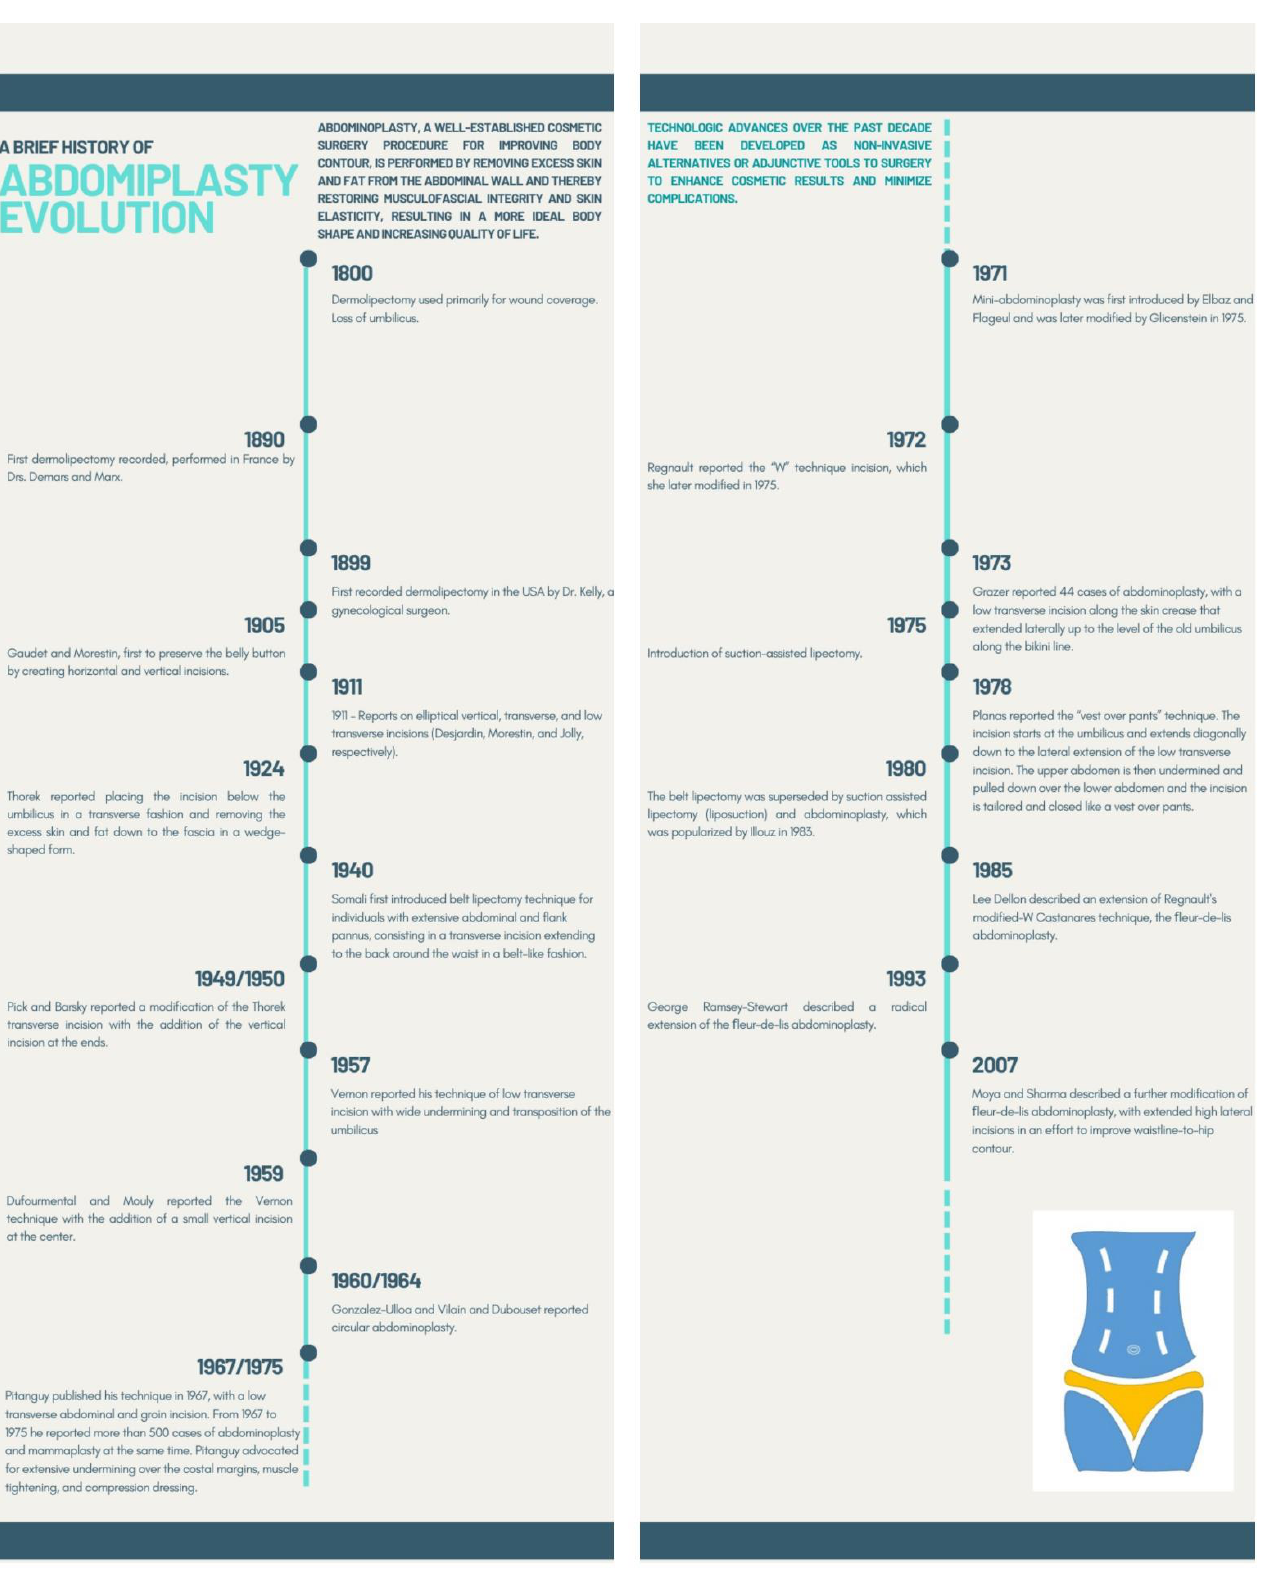
Figure 5. Timeline illustration showing the evolutionary history of abdominoplasty techniques. An alternative technique used to address the lax and expanded horizontal component of the abdominal wall is the fleur-de-lis technique. The name comes from the way the pattern is marked (in the shape of a fleur-de-lis), and it has both a horizontal and